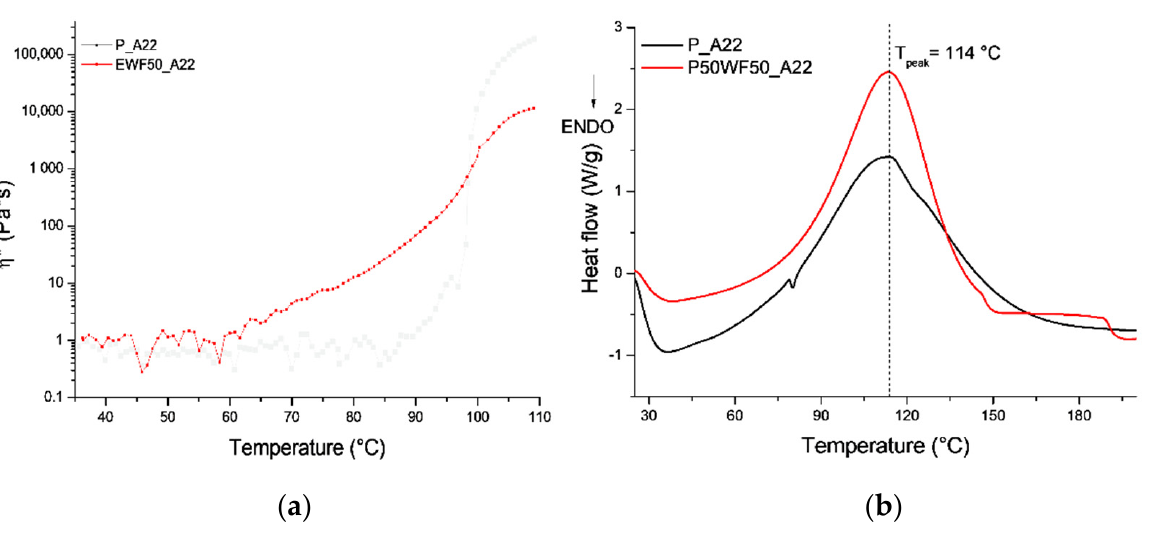
in Figure 4a. This indicates that in the presence of EWF, the crosslinking reaction of the system is accelerated.